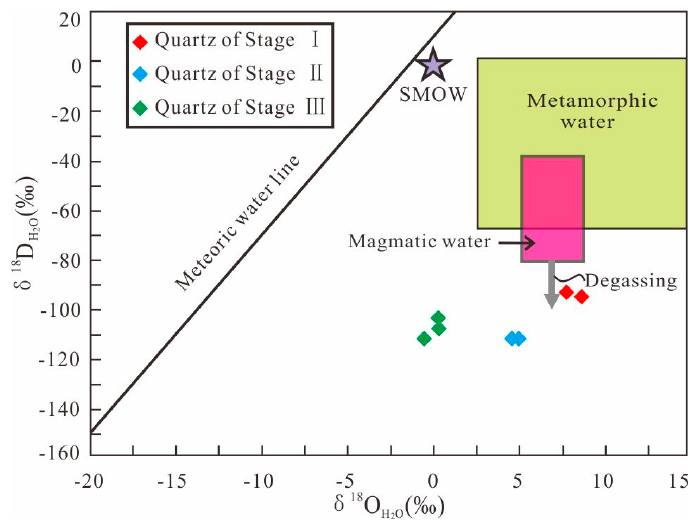
Figure 9. The δ 18 O H2O - δ 18 D H2O diagram of the ore-forming fluid of the Chuduoqu Pb-Zn-Cu deposit (after [45]).